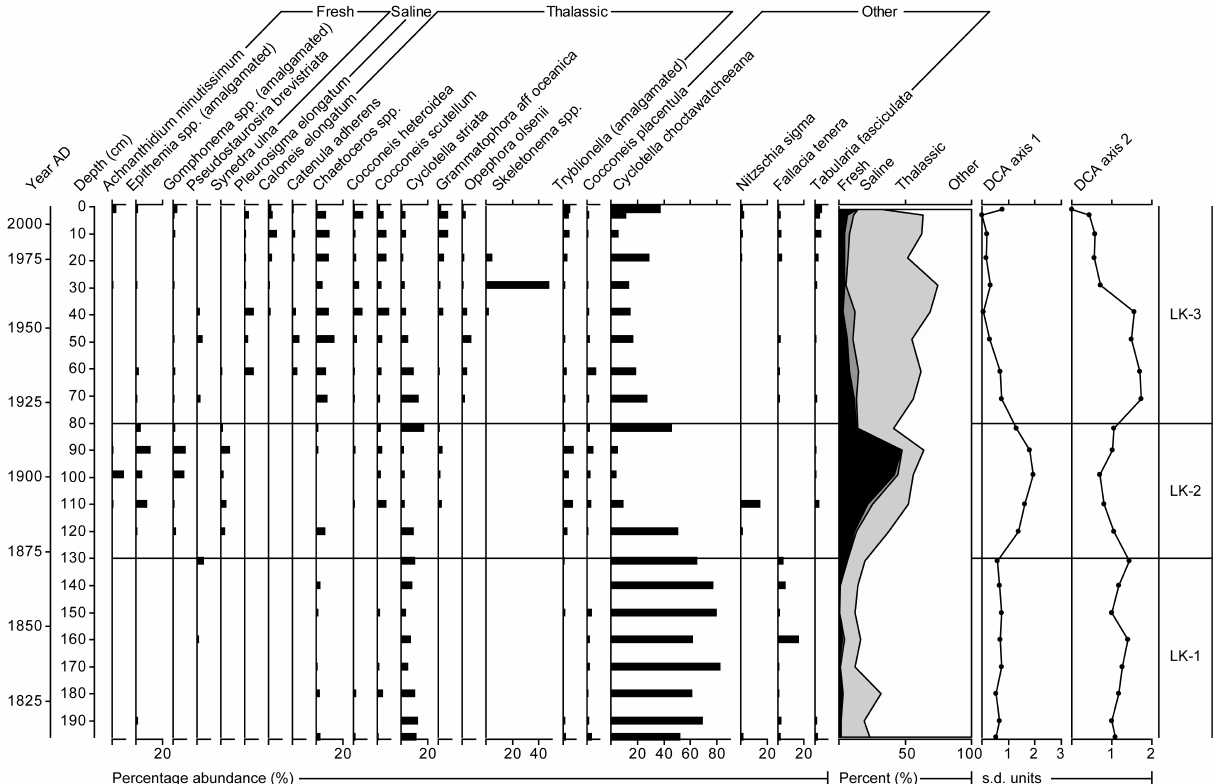
Figure 4. Profiles of diatom species abundance (percentage of total species count) grouped based on water salinity (fresh, saline, thalassic and other). Fresh indicates diatoms found at salinities <5, saline indicates species expected to grow at high salinity within estuaries, and thalassic species are expected to be found exclusively in the coastal ocean. Other refers to species typical of intermediate salinity within estuaries and lagoons. Detrended correspondence analysis (DCA) axes 1 and 2 are also shown with